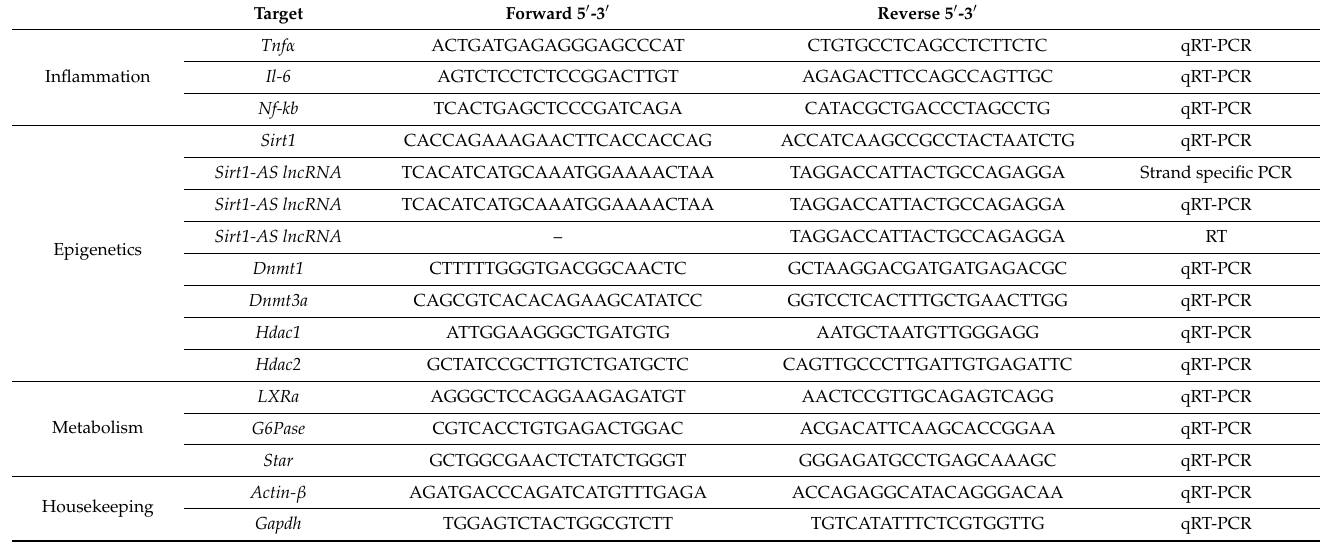
Table 7. Primers used in the